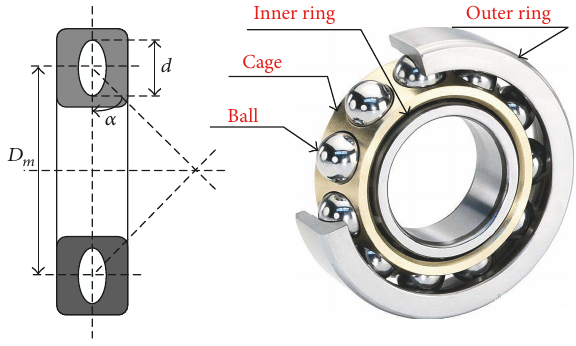
Figure 1: Structure of a ball